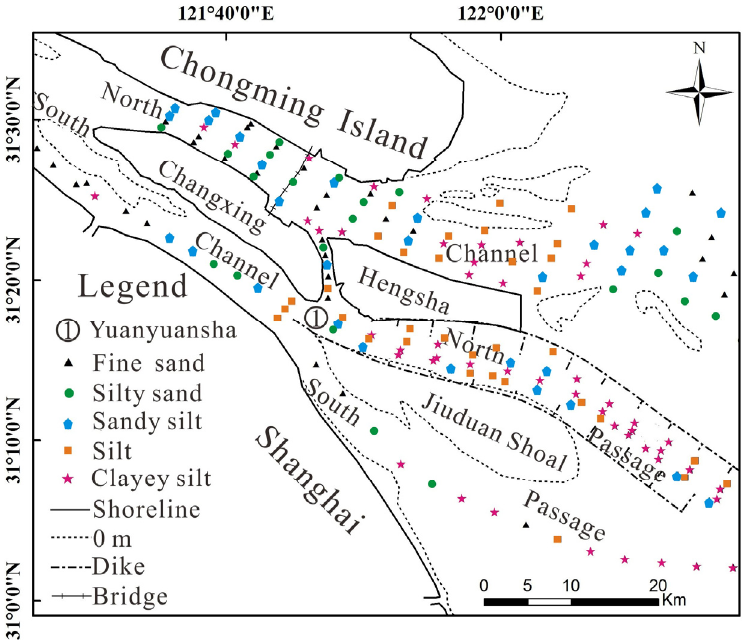
Figure 4. Types of sea-bottom sediment in the Yangtze River estuary in the recent years. Table 2. Types and grain size distribution of sea-bottom sediment in the Yangtze estuary.